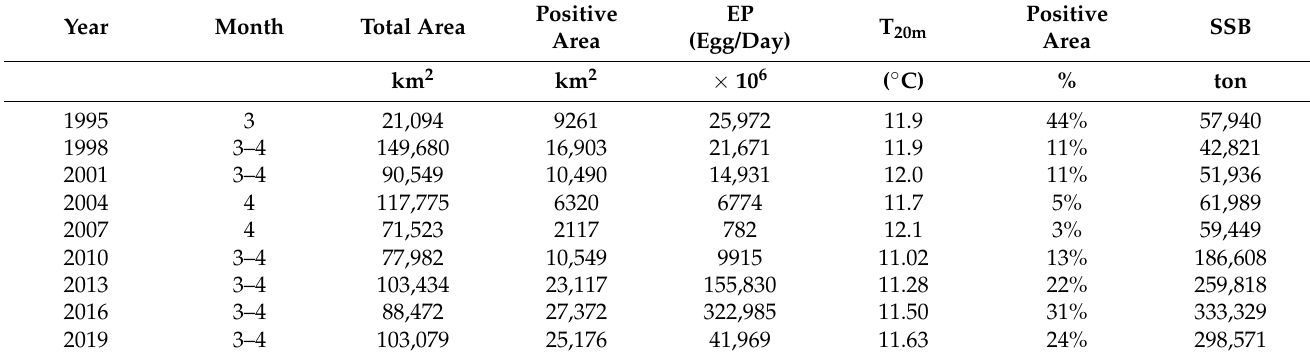
Table 4. The annual evolution of the daily hake egg production estimates from 1995 to 2019. EP: Daily egg production; positive area: Areas with hake egg; T 20m : Temperature at 20 m depth; and SSB: Hake spawning stock biomass estimated in WGBIE